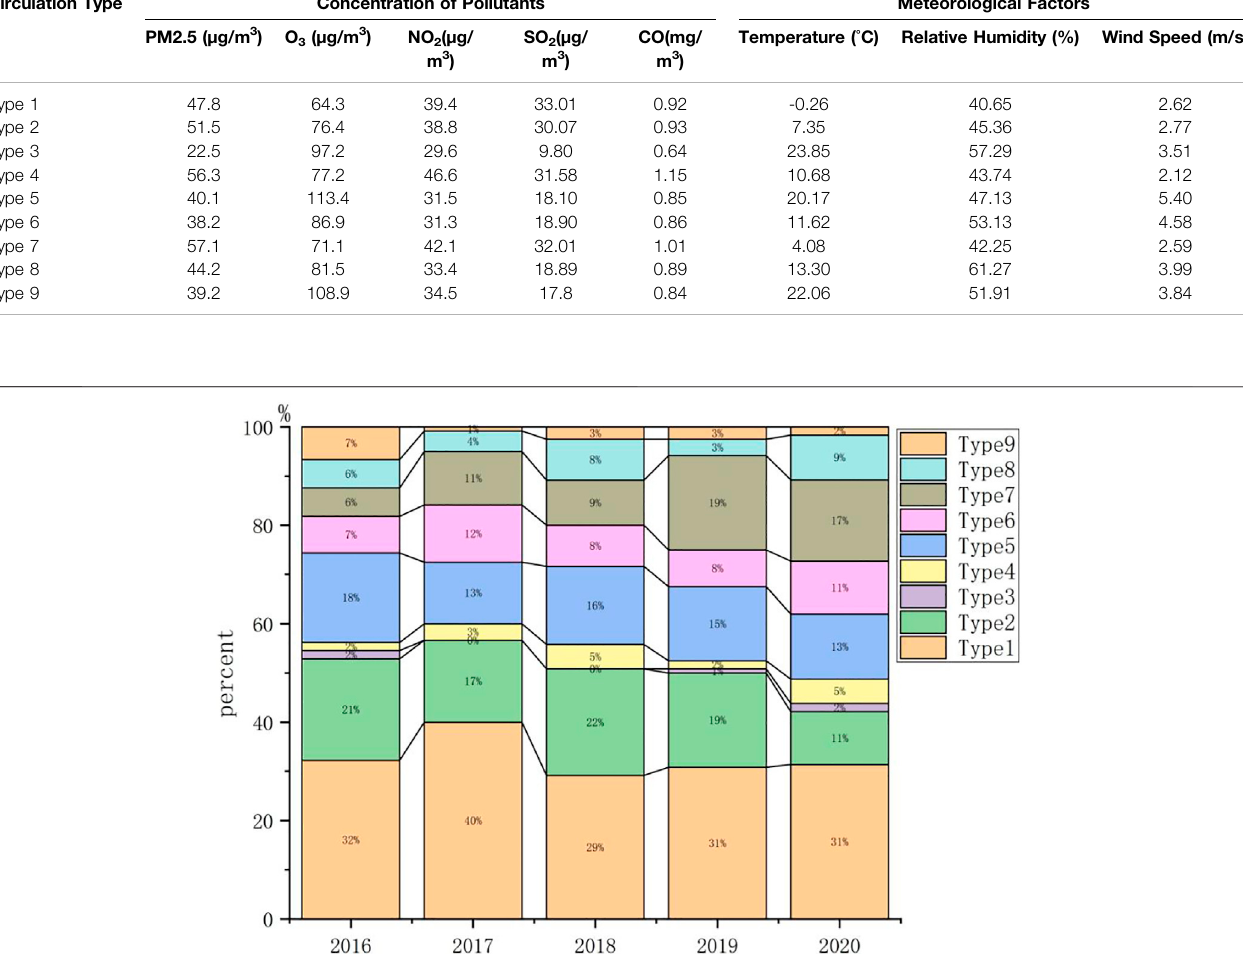
TABLE 1 | Average concentrations of the fi ve major atmospheric pollutants (PM2.5, O 3 , NO 2 , SO 2 , and CO) of the nine circulation types in Northeast China, and values of local meteorological elements (temperature, relative humidity, and average wind speed) during 2016 – 2020. Circulation Type